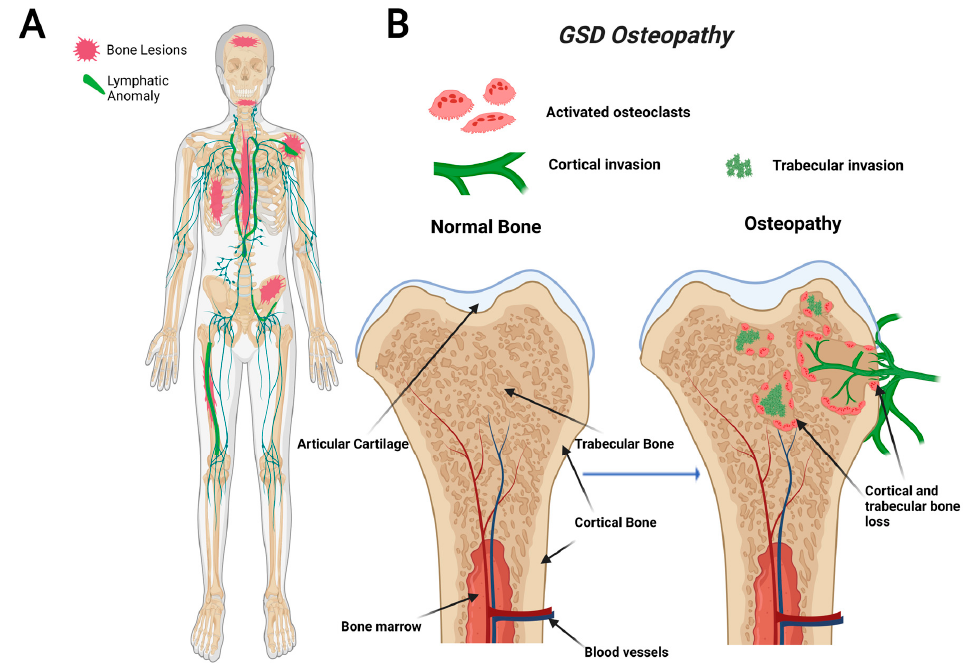
Figure 1. Visual representation of symptoms associated with Gorham-Stout Disease (GSD). GSD patients have regionally aggressive bone loss caused by abnormal lymphatic invasion ( A ).